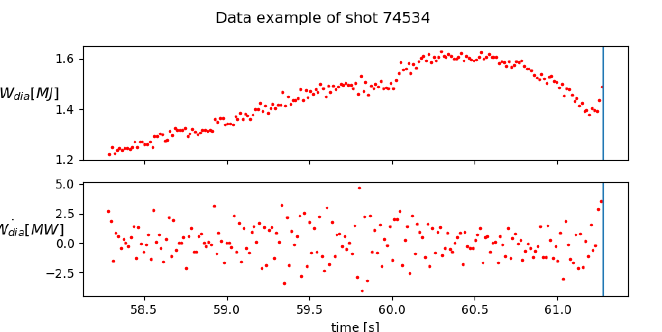
Figure 5. Example of diamagnetic energy and its time derivative, showing the noise on the signals. The vertical line is the moment of disruption.